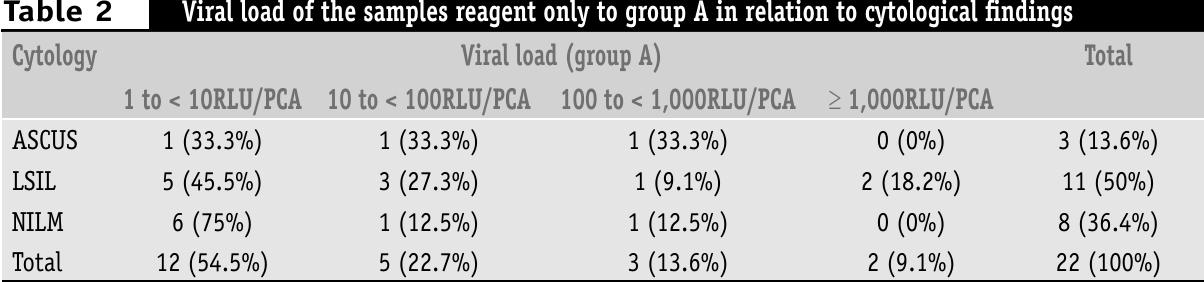
Viral load of the samples reagent only to group A in relation to cytological findings